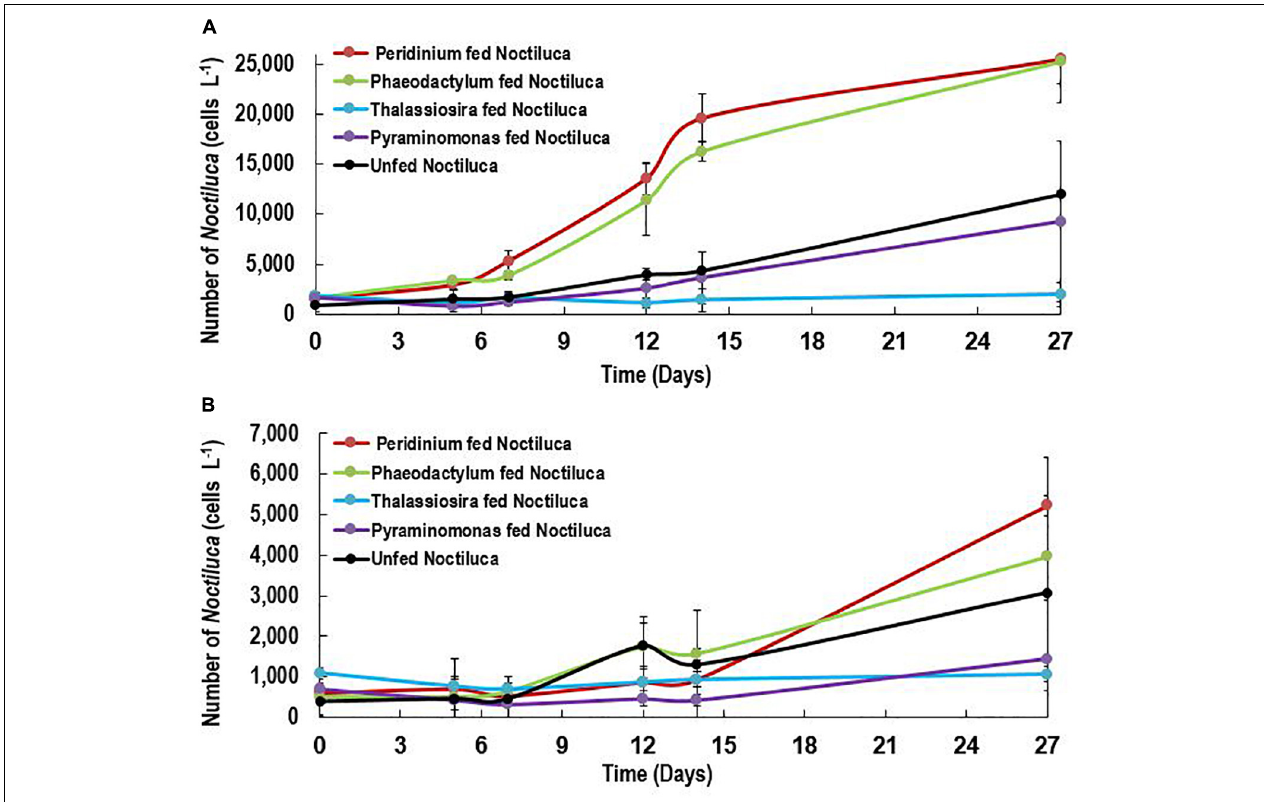
FIGURE 2 | (A,B) Growth response (Cells L - 1 ) of unfed Noctiluca and Noctiluca fed with prey and exposed to (A) optimal light (250 µ E m - 2 s - 1 , HL) (B) low light (10 µ E m - 2 s - 1 , LL). Data points represent means ± SE ( n =